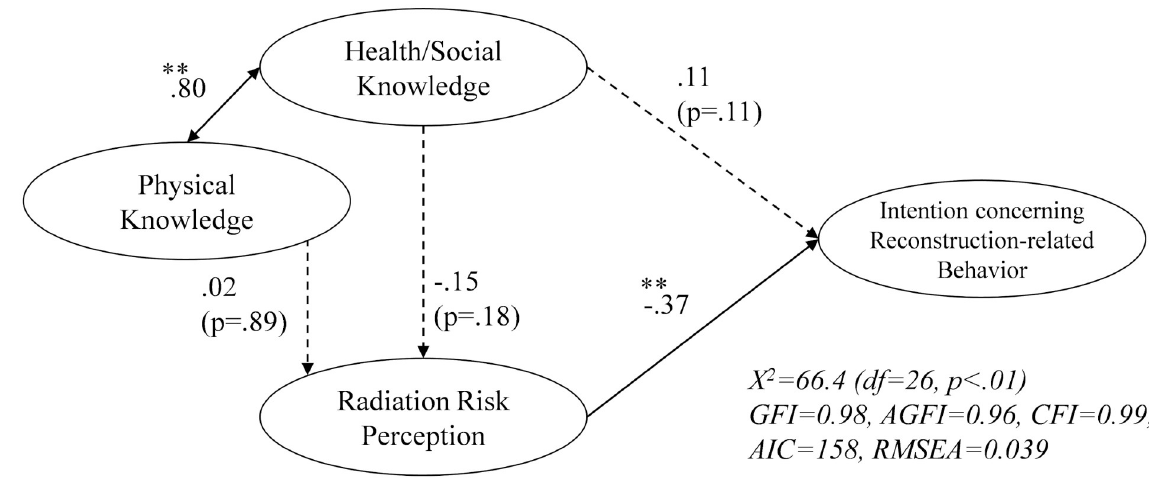
Fig 3. Estimated model of reconstruction-related behavior (P group). �� p < .05, � p < .10. The respondents in P group (n = 223) answered that Fukushima is recovering.